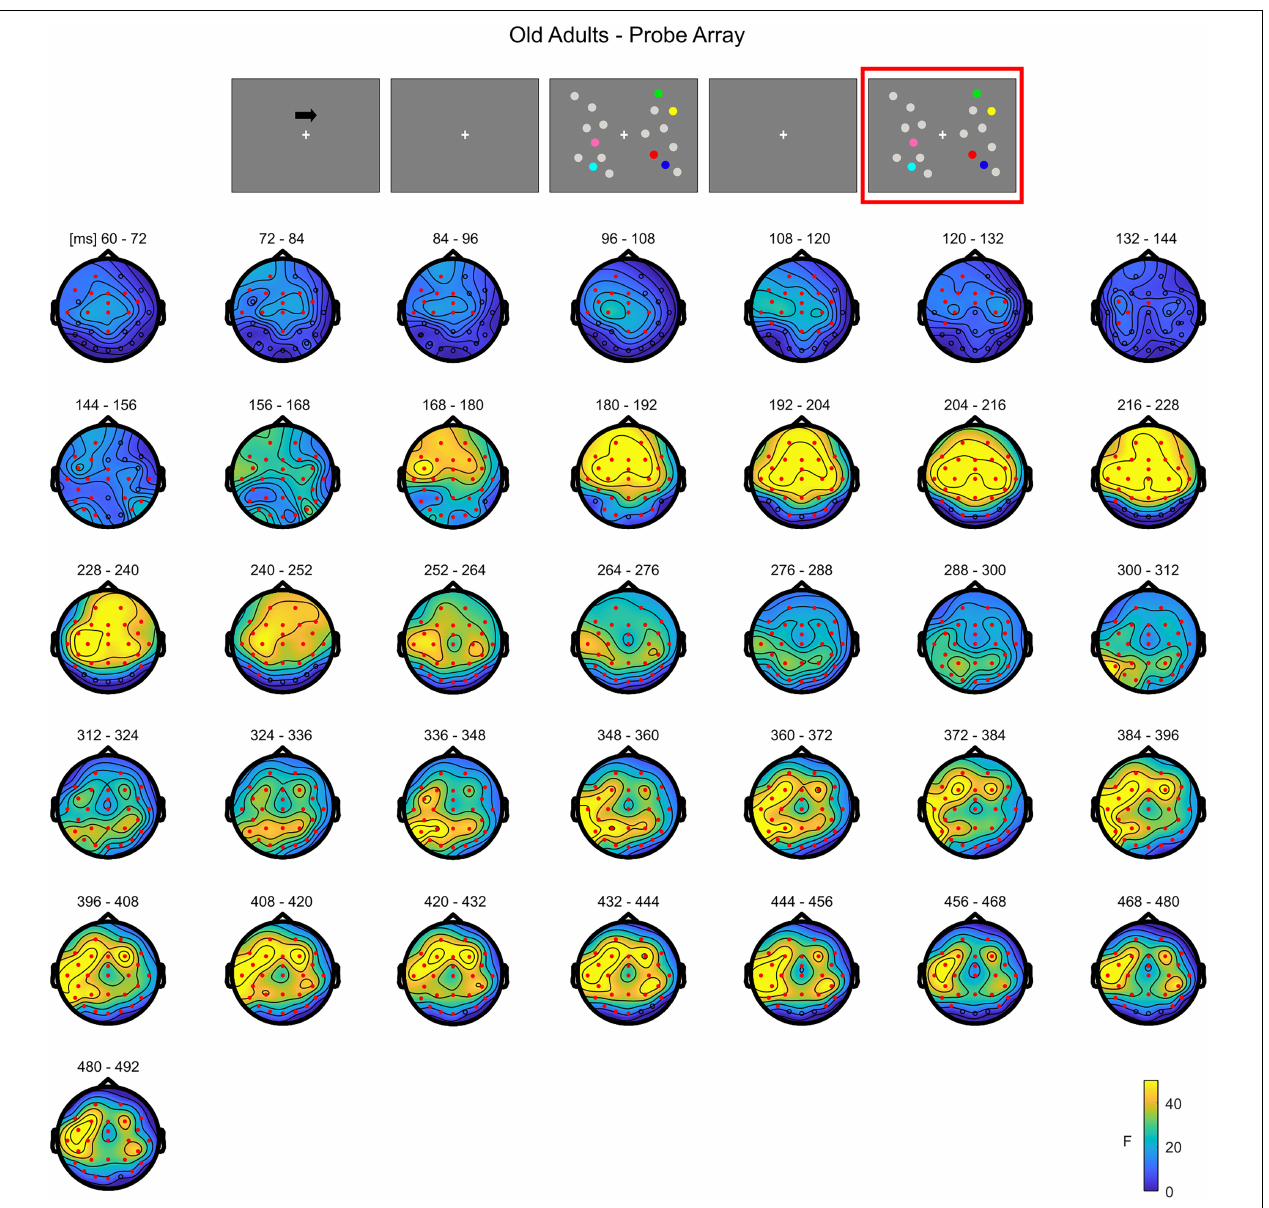
FIGURE 8 | Cluster-based permutation ANOVA results during item comparison in the Older group. The spatio-temporal evolution of the significant Load effect is represented through topographical maps of the clusters averaged in bins of 12 ms. Only significant time windows are depicted (for the complete time course, see Supplementary Figure 5 ). Red dots represent the significant effect. The color bar represents the range of F -values. Left and right channels are set as contralateral and ipsilateral to targets,